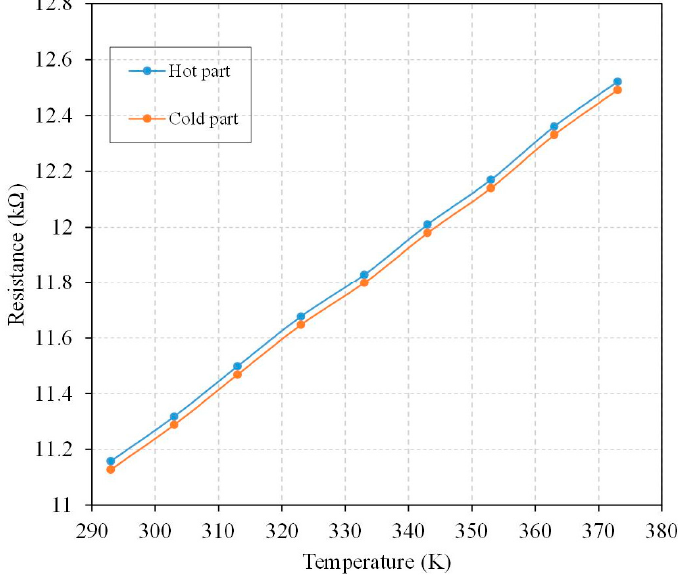
Figure 15. Measurement of resistance for the temperature sensors under various temperatures.